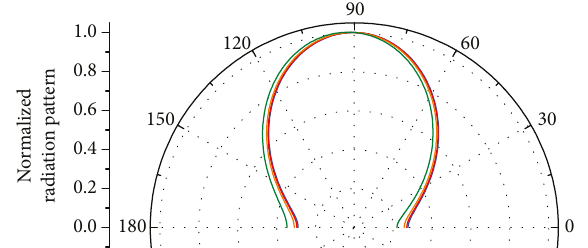
Figure 13: Normalized E plane radiation pattern of the HB antenna: = 5 mm — blue curve; z =10mm — red curve; z = 15 mm — orange z c c c curve; and z =20mm — green curve. c = 140mm ; W = 140 mm ). Table 5: HB antenna dimensions ( W z y Dimension